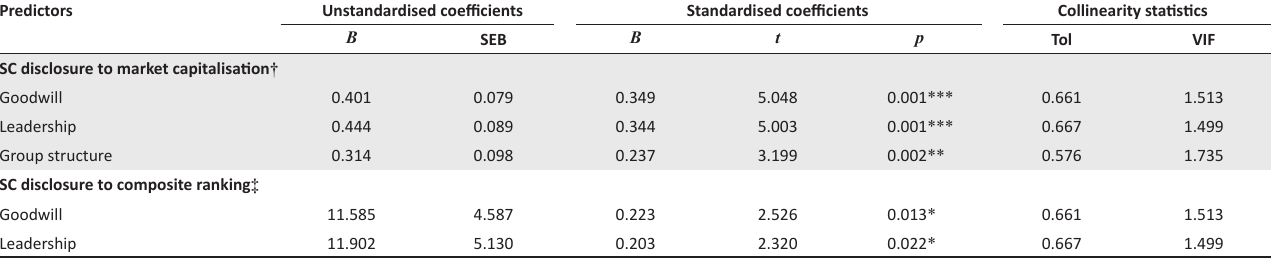
TABLE 4: Multiple regression of structural capital and organisational performance ( N = 150).